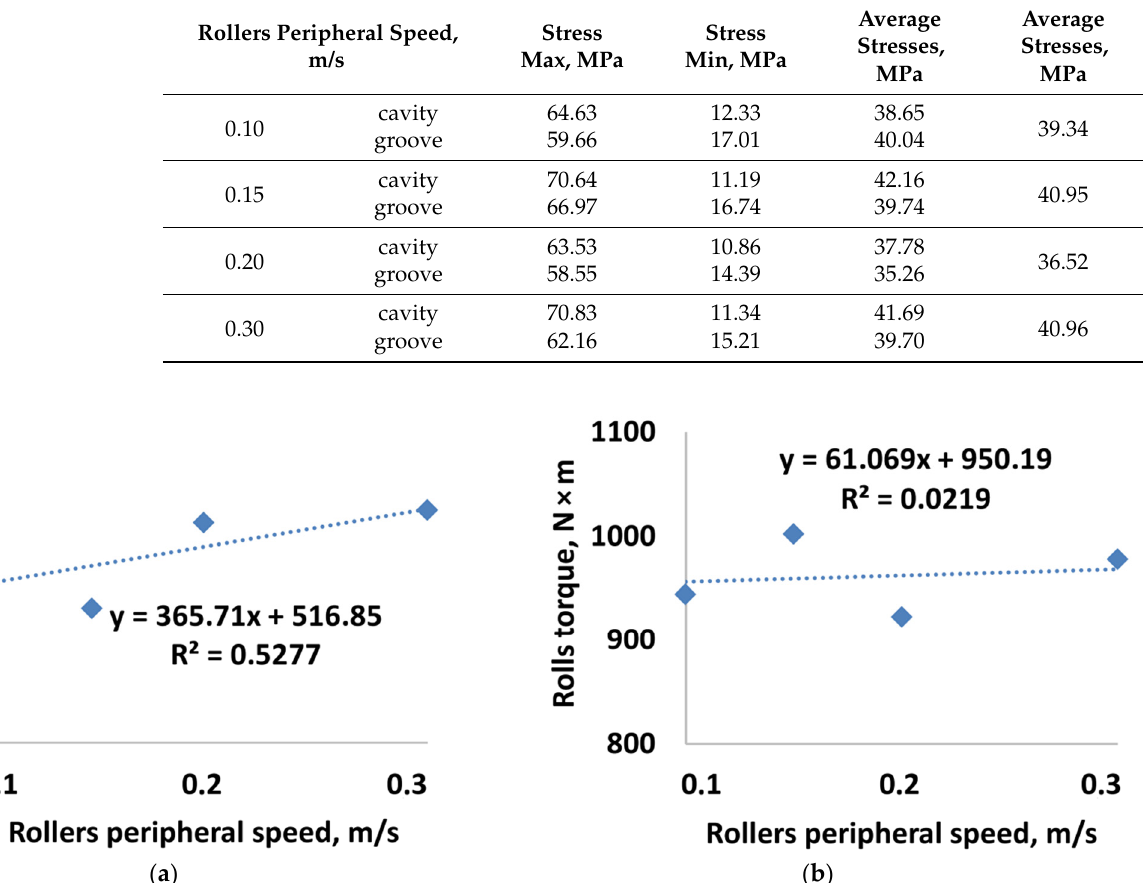
Table 3. Characteristics of stresses on the surfaces of the forming elements during briquetting of copper ore concentrate.